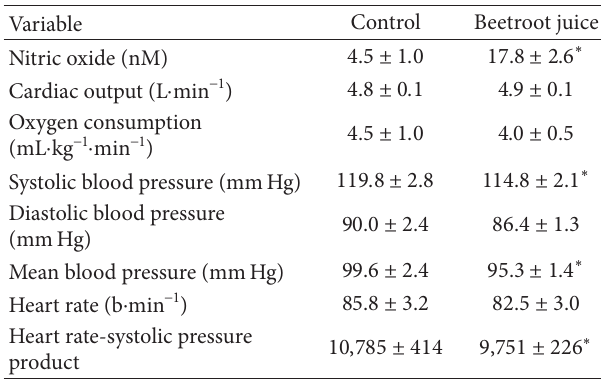
Table 2: Effects of beetroot juice treatment at